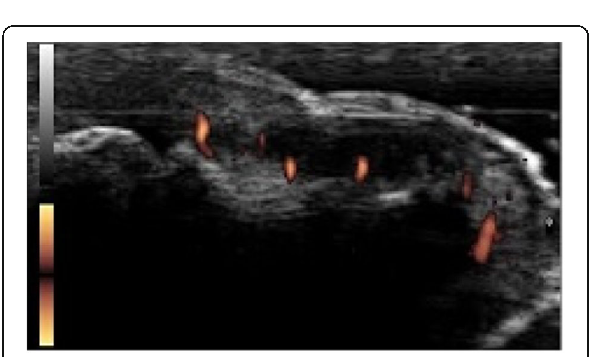
Fig. 4 (abstract P364).